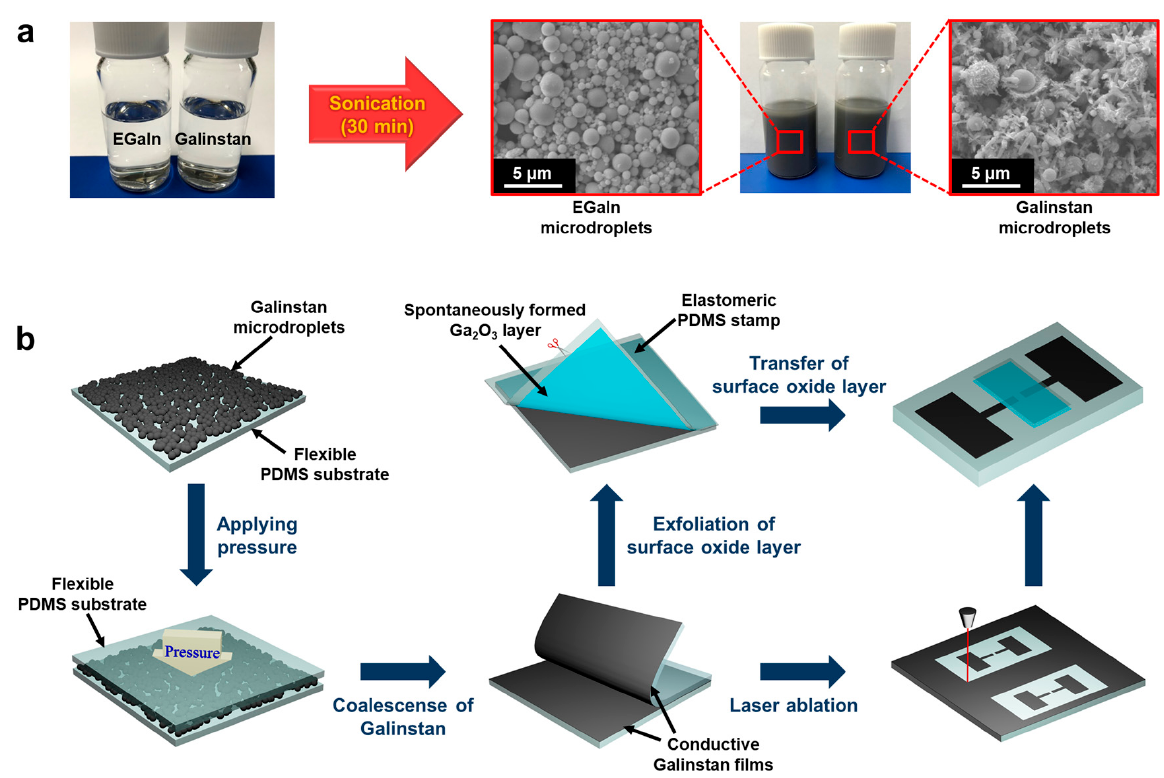
Figure 1. ( a ) Preparation of suspensions comprising EGaIn and Galinstan microdroplets by sonication. ( b ) Schematic illustration of the fabrication of flexible solar-blind photodetector using Galinstan microdroplets.